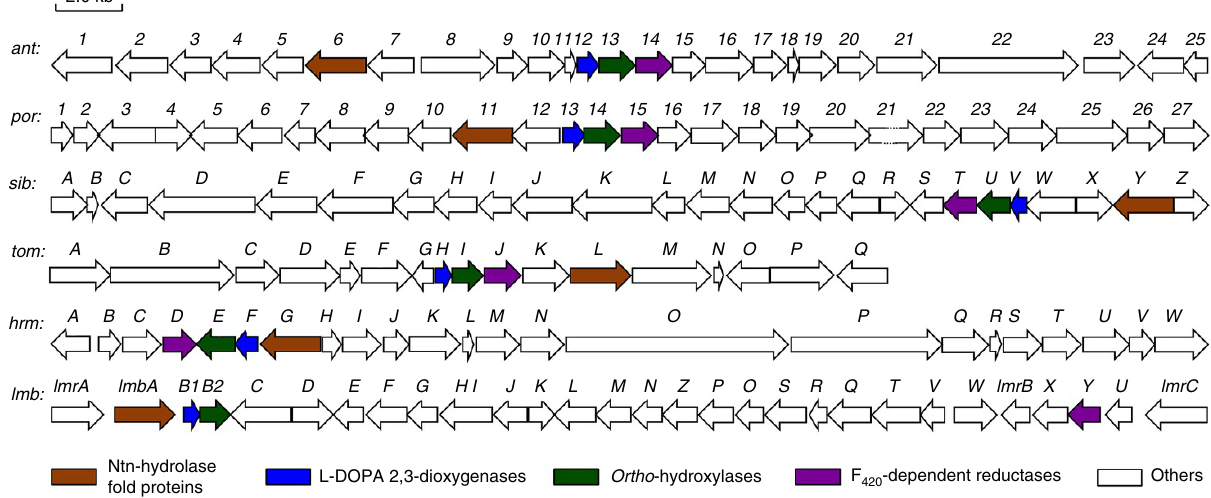
Figure 2 | Comparative analysis of available ALDP-related biosynthetic gene clusters. The genes coding for ALDP formation are coloured. ant , for anthramycin; por , for porothramycin; sib , for sibiromycin; tom , for tomaymycin; hrm , for hormaomycins and lmb , for lincomycin A. For sequence identities of deduced proteins, LmbA is homologous to Ant6 (72.3%), Por11 (72.9%), SibY (58.0%), TomL (50.0%) and HrmG (64.6%); LmbY is homologous to Ant14 (49.8%), Por15 (48.2%), SibT (53.5%), TomJ (50.2%) and HrmD (46.3%); LmbB1 is homologous to Ant12 (40.8%), Por13 (44.6%), SibV (54.4%), TomH (52.8%) and HrmF (46.2%); and LmbB2 is homologous to Ant13 (31.2%), Por14 (30.9%), SibU (38.7%), TomI (37.3%) and HrmE